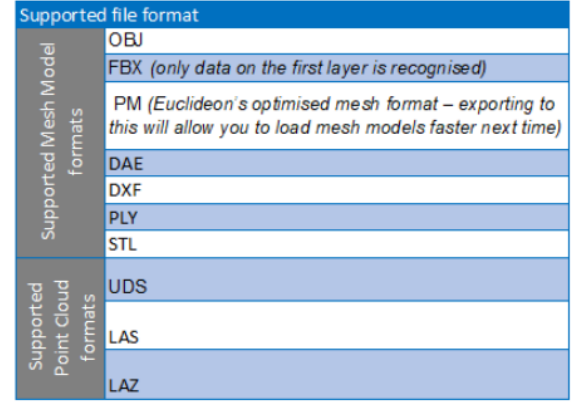
Table 1. Figure 2: file format accepted by the proprietary software UD stream of the Hologram